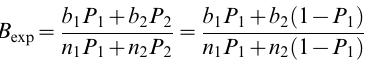
Gene symbol Cytoband